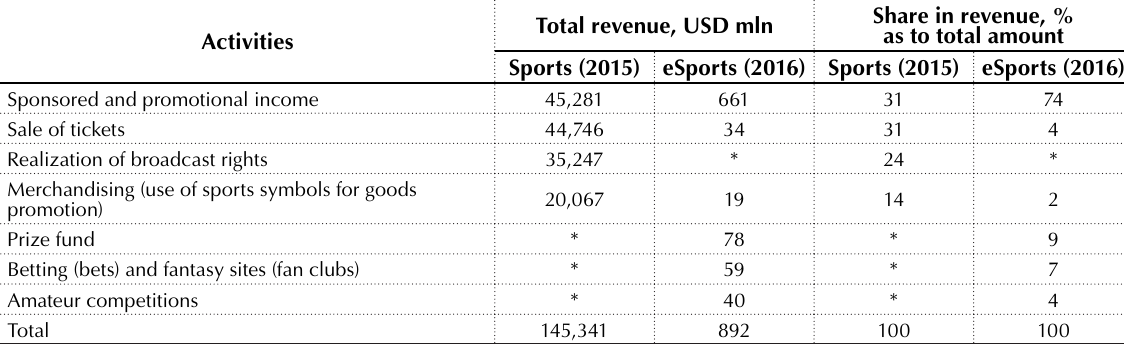
Table 2. Revenue estimates in sports and